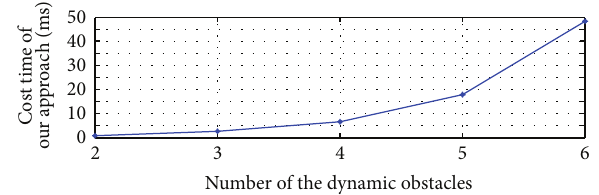
Figure 10: Cost time of our approach according to the number of the dynamic obstacles.